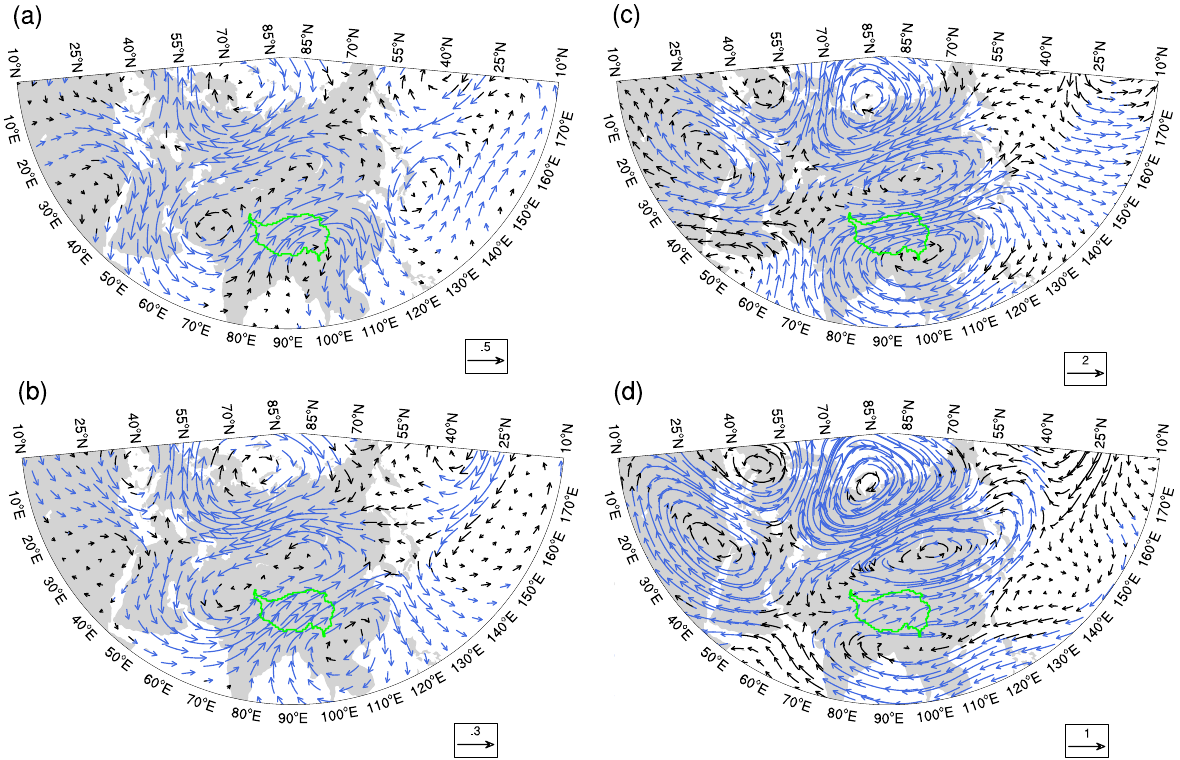
Fig. 3 Observed and simulated wind fi elds. a, b Linear trends of horizontal wind fi elds (m s − 1 decade − 1 ) at 200 hPa ( a ) and 500 hPa ( b ) obtained by the BKS experiment; c, d Regressed horizontal wind fi elds (m s − 1 ) at 200 hPa ( c ) and 500 hPa ( d ) against the normalized PC2 of winter SAT anomalies in the region of Eurasia from 1979 to 2018 derived from ERA5. Blue streamlines indicate the regions exceeding the 90% statistical con fi dence level. The TP domain is outlined by green curves with the surface altitude above 2500 m.